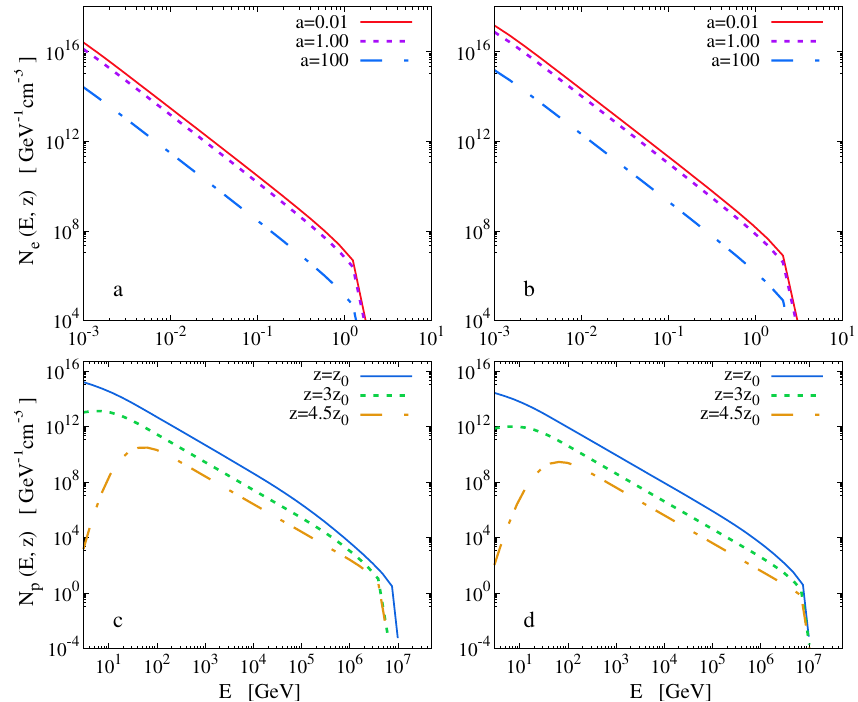
Figure 4. Energy distributions for relativistic electrons and protons produced in Cygnus X-1 ( a , c ) and LMC X-1 ( b , d ). In the electrons’ case, the solid lines refer to the proton-to-electron ratio α = 0.01, the dashed lines to α = 1.00, and the dashed-dotted ones describe electron distributions assuming that α = 100 (i.e., they correspond to a purely hadronic model). For protons, the solid lines refer to particle production at the jet’s base z 0 , while the dashed or dotted-dashed ones refer to different distances to the central object, covering the length of the acceleration